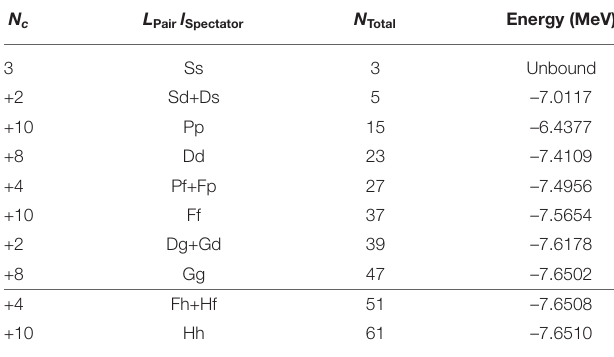
TABLE 11 | Triton binding energy convergence for the hyper-spherical harmonics method [24] in the number of channels, N c , classified according to the orbital angular momentum of the pair L Pair and the spectator l spectator in the triton as the number of total accumulated channels, N Total , is increased.